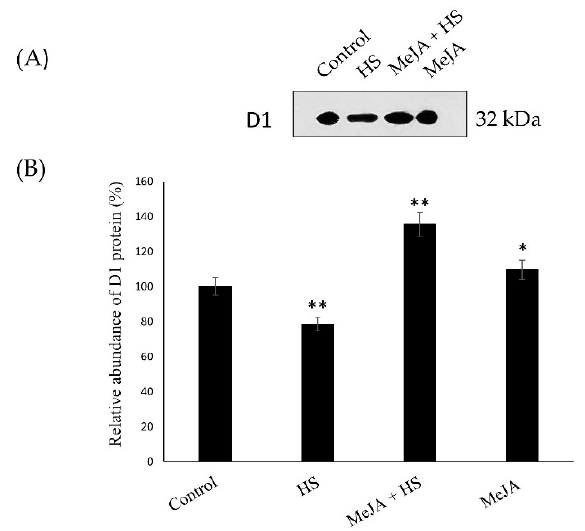
Figure 4. Immunoblot studies of thylakoid protein (D1) acquired from wheat leaves at 30 DAS. Plants were treated with MeJA (10 µM) at 42 °C (heat stress) or 25 °C (no stress). ( A ) Immunoblotting was performed with specific antibodies raised against the D1 protein. ( B ) Quantitative data for D1 protein in wheat leaves under heat stress after MeJA treatment. Results are presented relative to the respective controls (control, 100%, n = 4). Significantly different values are marked with an asterisk (* p < 0.05, ** p < 0.01). DAS, days after sowing; HS, heat stress; MeJA, methyl jasmonate.